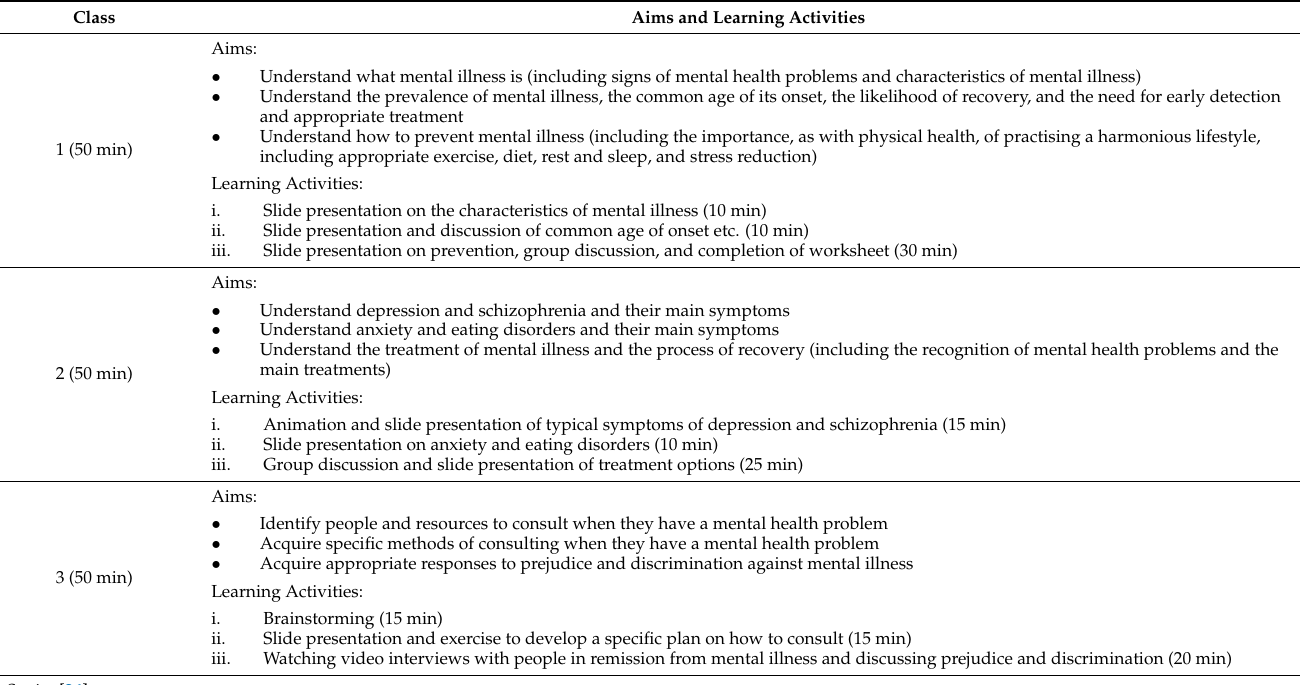
Table 1. Contents of the “Sanita” mental health literacy educational